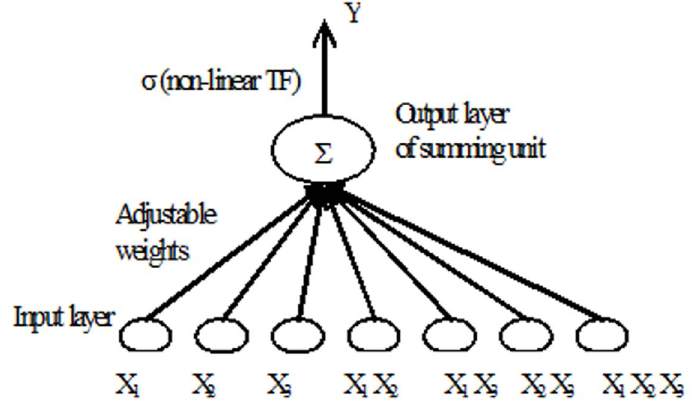
Figure 1. Functional Link Neural Network.